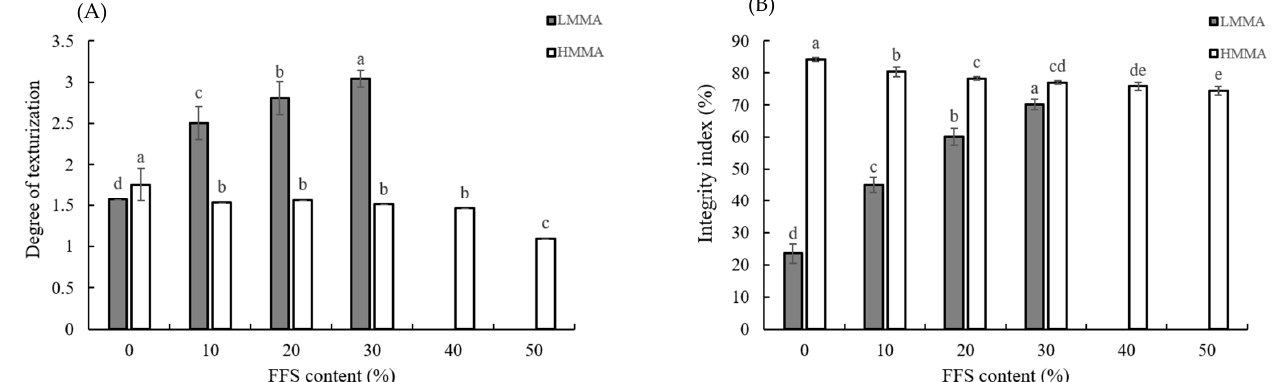
Figure 3. Degree of texturization ( A ) and integrity index ( B ) of extruded low- and high-moisture meat analogs with different full-fat soy (FFS) content. LMMA: low-moisture meat analog; HMMA: high-moisture meat analog. Different letters (a–e) above the bars indicate the significantly different for each extrusion type (LMMA and HMMA) ( p ≤ 0.05) by Duncan’s multiple range tests